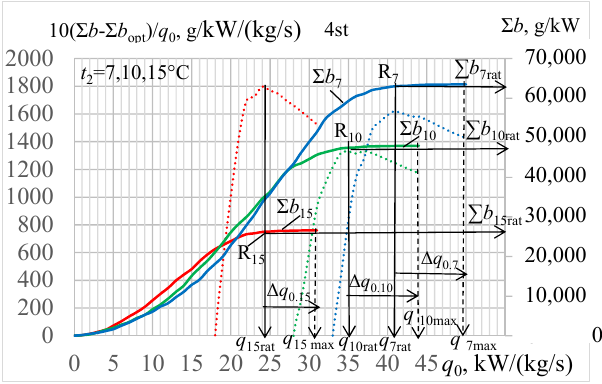
(cid:80) (cid:80) (cid:80) b and its relative increments ( b − b opt ) / q 0 · for t a 2 = 7, 10 (cid:80) (cid:80) b − b opt ) / q 0 .